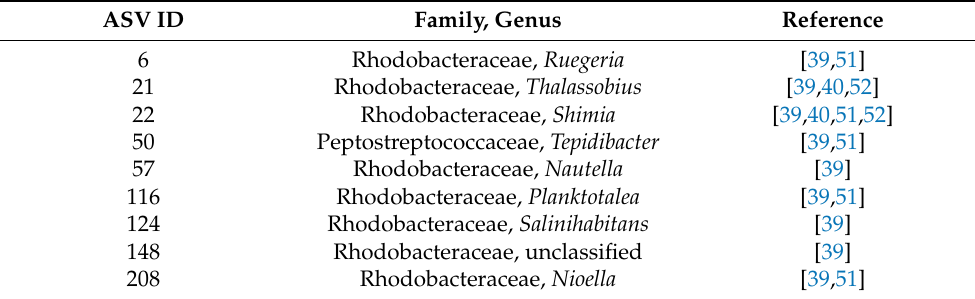
Table 2. Significantly differentiated amplicon sequence variants (ASVs) enriched in the lesion tissue of ≥ 2 of the coral species examined in this study: Colpophyllia natans , Pseudodiploria strigosa , Montastraea cavernosa , Orbicella faveolata , and Siderastrea siderea . NCBI’s Basic Local Alignment Search Tool (BLAST) confirmed that the ASVs listed here match sequences published in other stony coral tissue loss disease